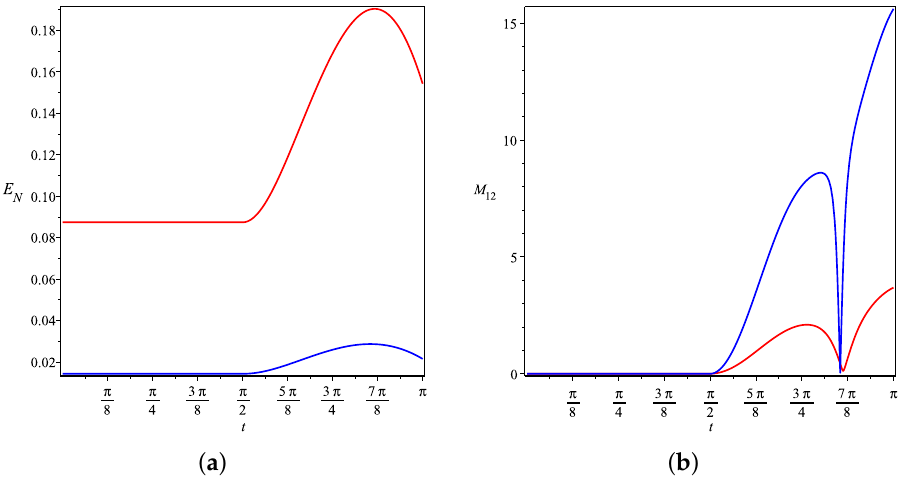
Figure 7. ( a ) Dynamics of entanglement quantified by logarithmic negativity E N ( t ) and ( b ) geometric average of excitations M 12 ( t ) = ( (cid:104) N 1 (cid:105)(cid:104) N 2 (cid:105) ) 1 2 , for (cid:101) = 0.99, J 0 = 0.01 (blue line) and (cid:101) = 0.9, J 0 = 0.1 = (red line), while ω 2 0